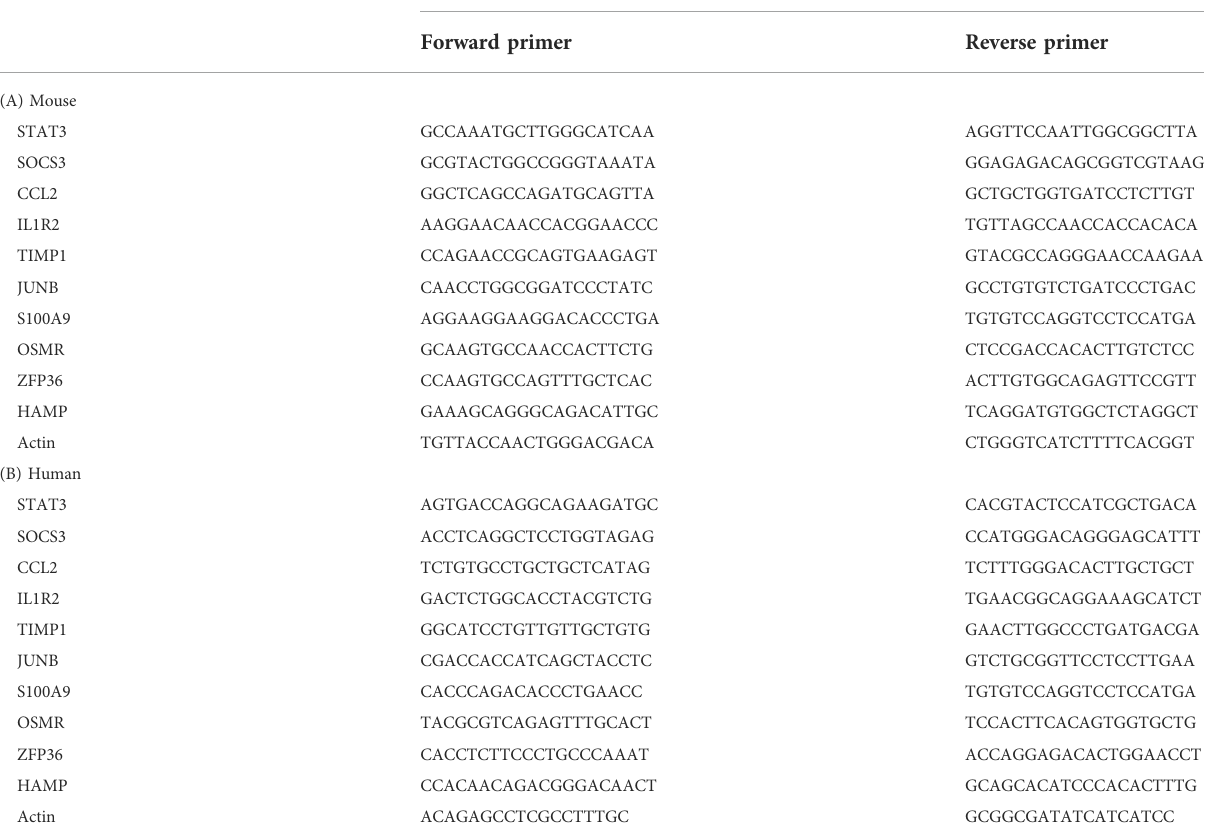
TABLE 1 Primers of top ten hub